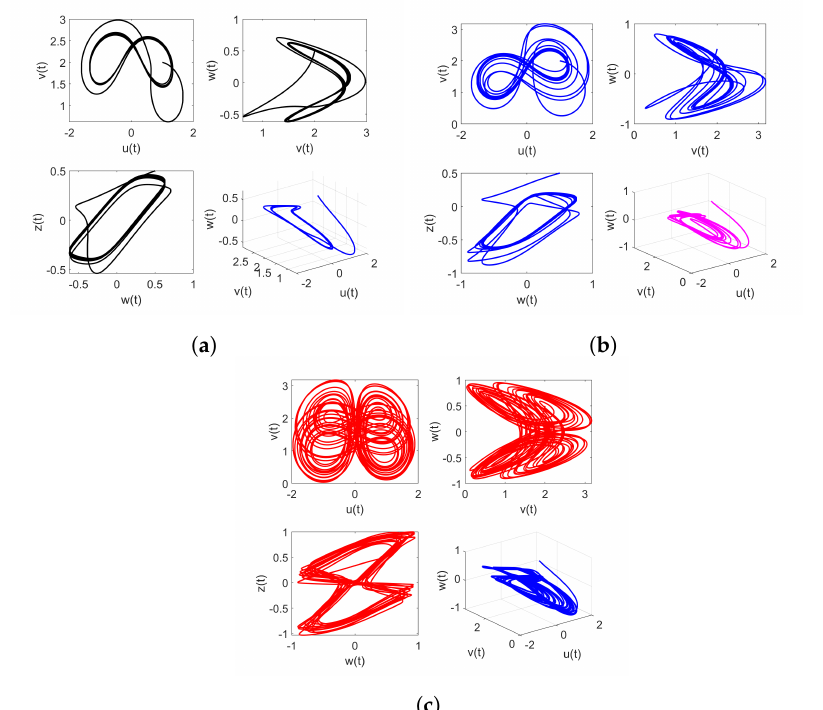
Figure 2. The phase portraits of the fractional order hyperchaotic finance model (1), obtained at the different values of σ : ( a ) σ = 0.8, ( b ) σ = 0.95, and ( c ) σ = 1.